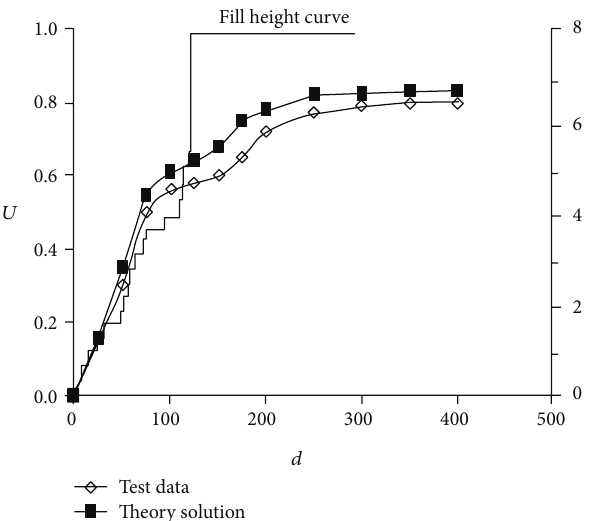
Figure 15: Variation of consolidation degree of the composite foun- dation.